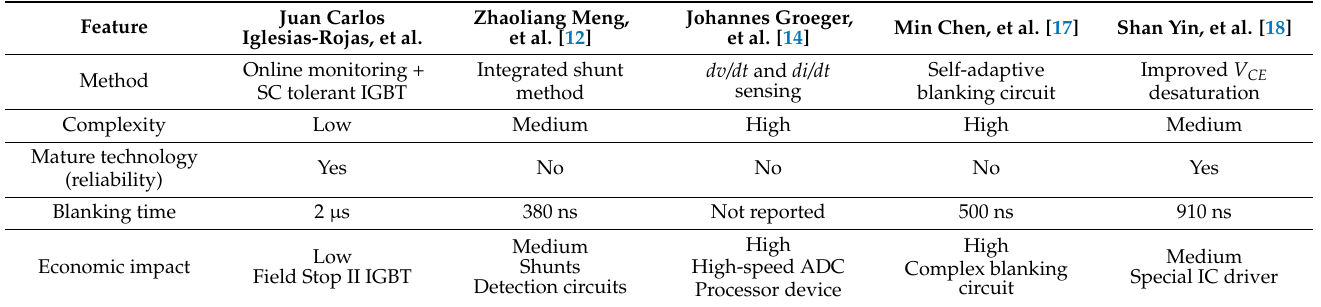
Table 3. Comparison of different methods for detecting and processing failures to improve IGBT